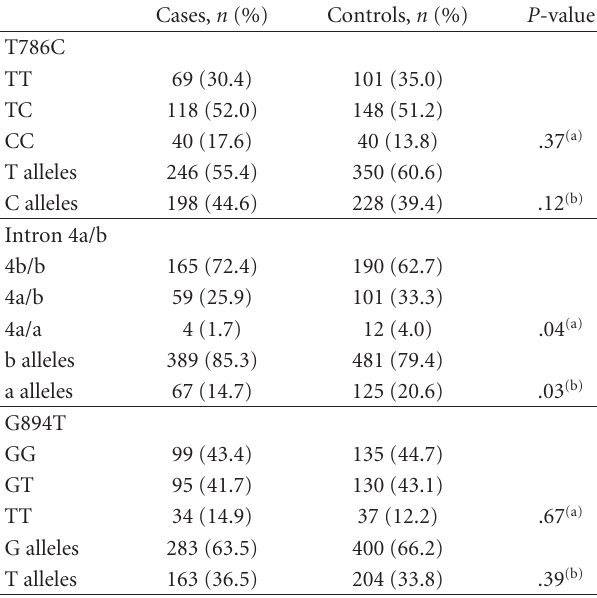
Table 2: Genotypic and allelic distributions of NOS3 polymor- phisms for cases and